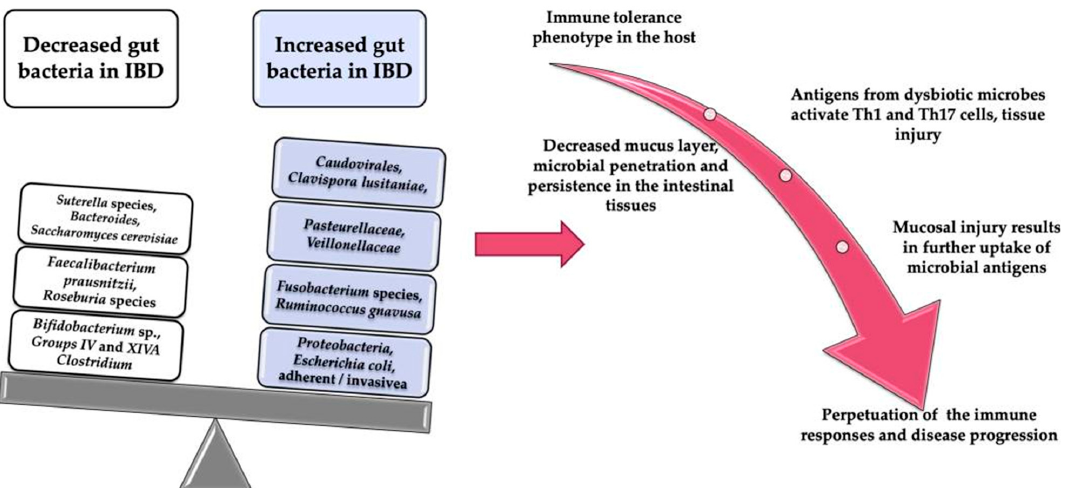
Figure 1. Altered gut bacteria implication in the pathogenesis of IBD. (Taken from Pavel et al., 2021 [38]).